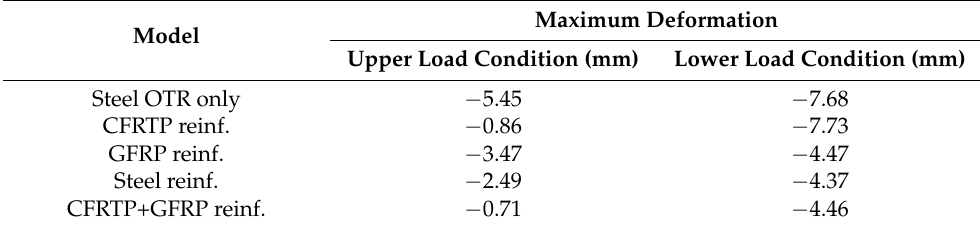
Figure 20. Maximum deformation results: ( a ) under upper bending load condition and ( b ) under lower bending load condition. Table 7. Maximum deformation results according to analysis conditions.